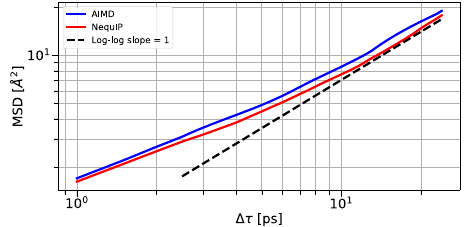
Fig. 5 Learning curves. Log-log plot of the predictive error on the water data set from 50 using NequIP with l ∈ {0, 1, 2, 3} as a function of training set size, measured via the force